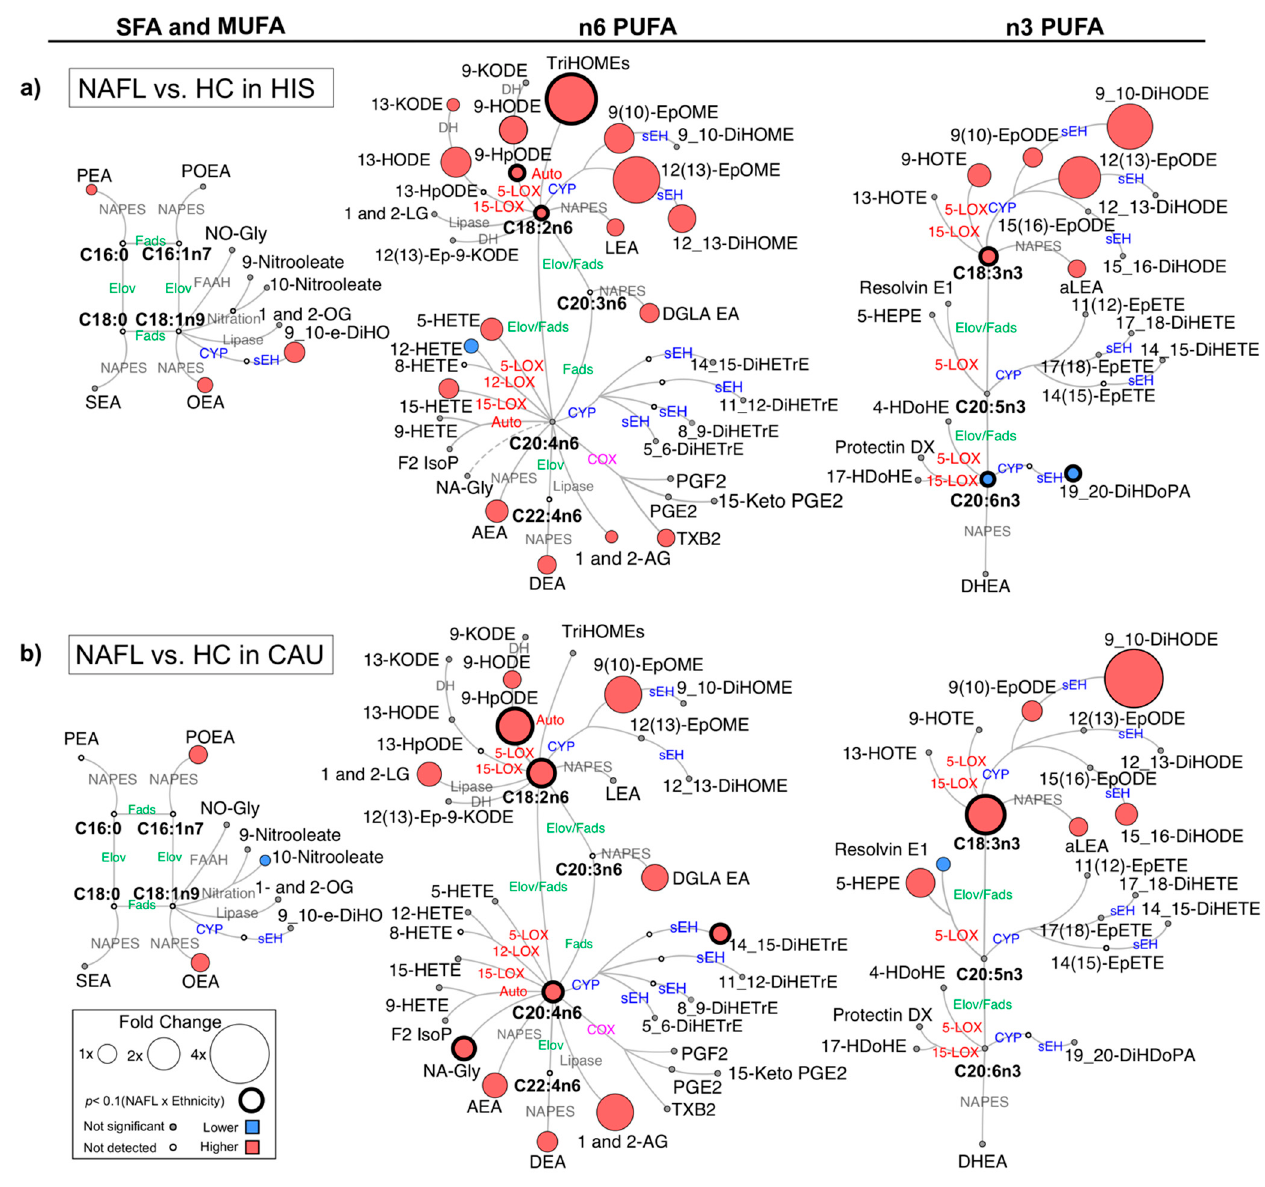
Figure 1. Differences in plasma polyunsaturated fatty acids (PUFAs) and lipid mediators between non-alcoholic fatty liver (NAFL) compared to healthy control (HC) in primary cohort. Metabolic network for ( a ) Hispanic (HIS); ( b ) Caucasian (CAU) illustrating saturated (SFAs), monounsaturated (MUFAs) and polyunsaturated fatty acids (PUFAs), including n-3 and n-6 PUFAs with pathways of oxylipins and endocannabinoids synthesis. Node size represents fold changes, calculated as (HC − NAFL)/HC. Node’s color represents the directionality of differences: higher in NAFL (red); lower in NAFL (blue); no change (grey). Shown are only lipids with differences between NAFL vs. HC ( t -test raw p < 0.05) and/or with interaction (ethnicity × NAFL) (ANCOVA raw p < 0.05). Lipids with interaction (ethnicity × NAFL) (ANCOVA raw p < 0.05) are marked with a solid circle. Means and p -values are detailed in Table S1. Fatty acids are described by number of carbons and double bounds of the fatty acyl moiety (i.e., C18:2n6). NAFL ( n = 10 HIS and 8 CAU); HC ( n =